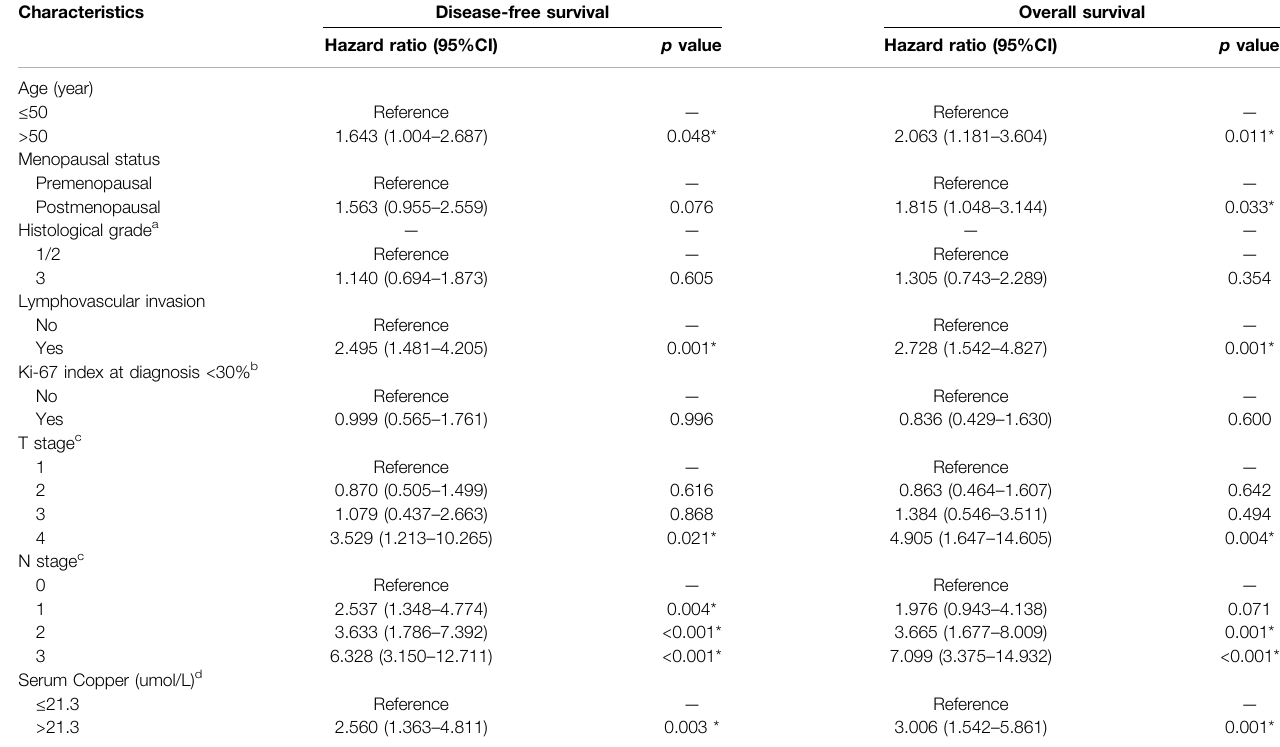
TABLE 2 | Univariate Cox regression analysis of disease-free survival and overall survival in women with breast cancer in the training cohort. Characteristics